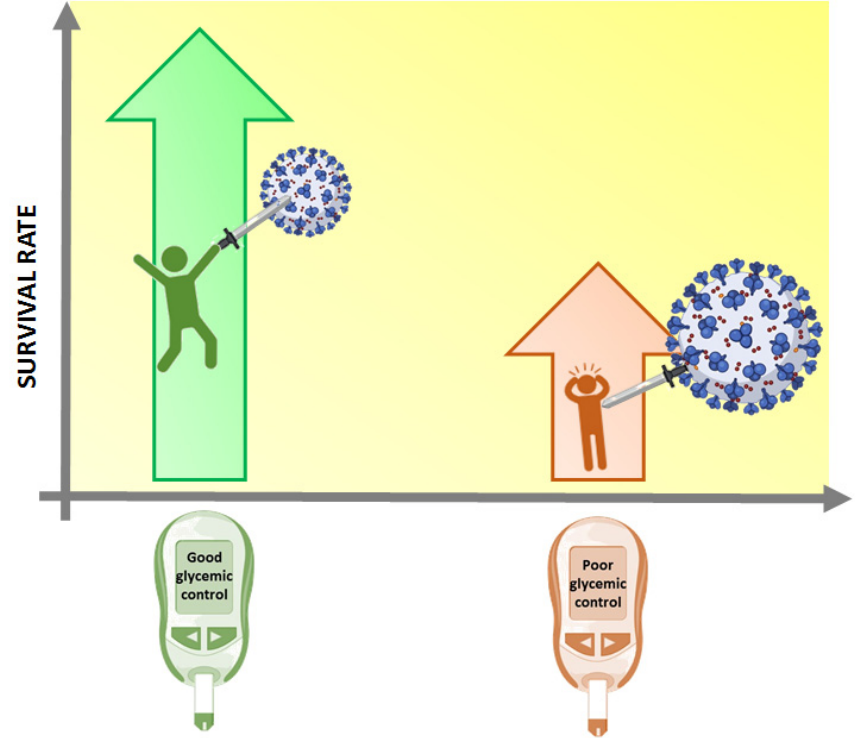
Figure 1. Impact of COVID-19 on patients with diabetes. Survival rate is dramatically reduced in subjects with diabetes infected with SARS-CoV-2. Created with BioRender.com.